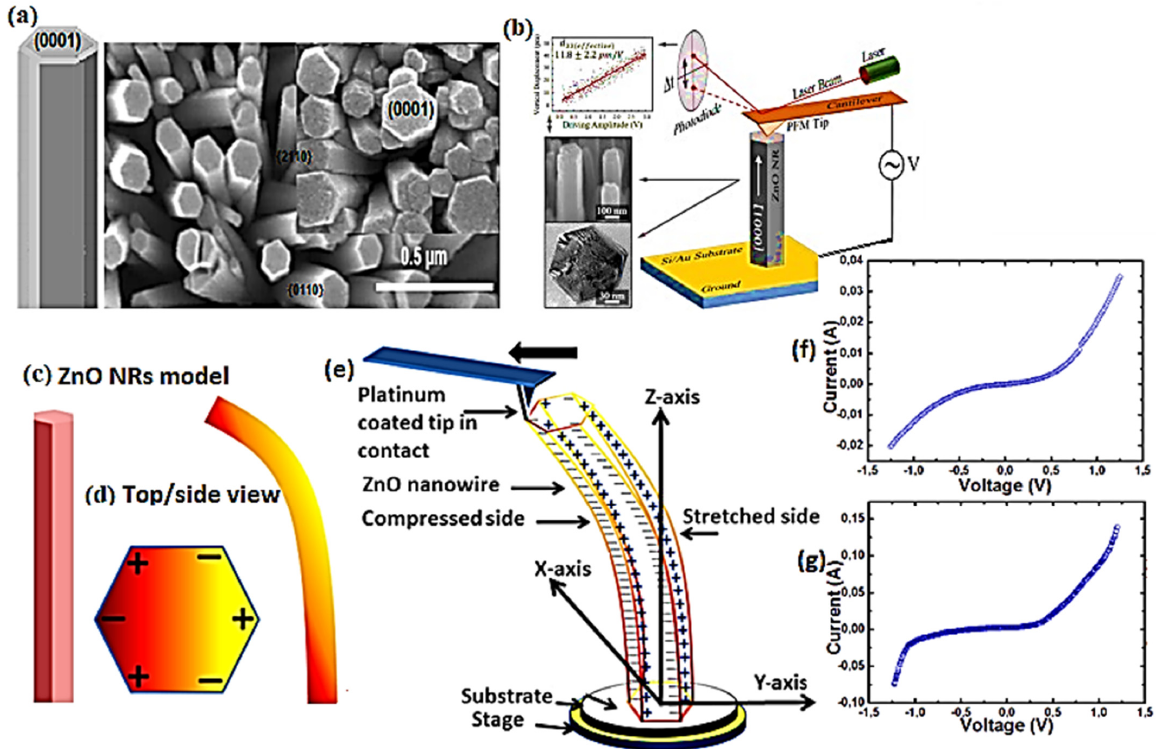
Figure 14. ( a ) FE-SEM image of ZnO nanorod arrays grown on a seeded substrate, with hexagonal (0001) surface. ( b ) PFM model with precise cantilever deflections on the nanorod. ( c , d ) Schematic (top view and side) view of a single ZnO NR. ( e ) 3D-model of ZnO NR during scanning by AFM tip. ( f , g ) Current-voltage (IV)-characteristics of two different samples. Reprinted with permission from ref. [89]. Copyright 2021 Elsevier. Reprinted with permission from ref. [146]. Copyright 2015 Elsevier. Reprinted with permission from ref. [159]. Copyright 2014 AIP